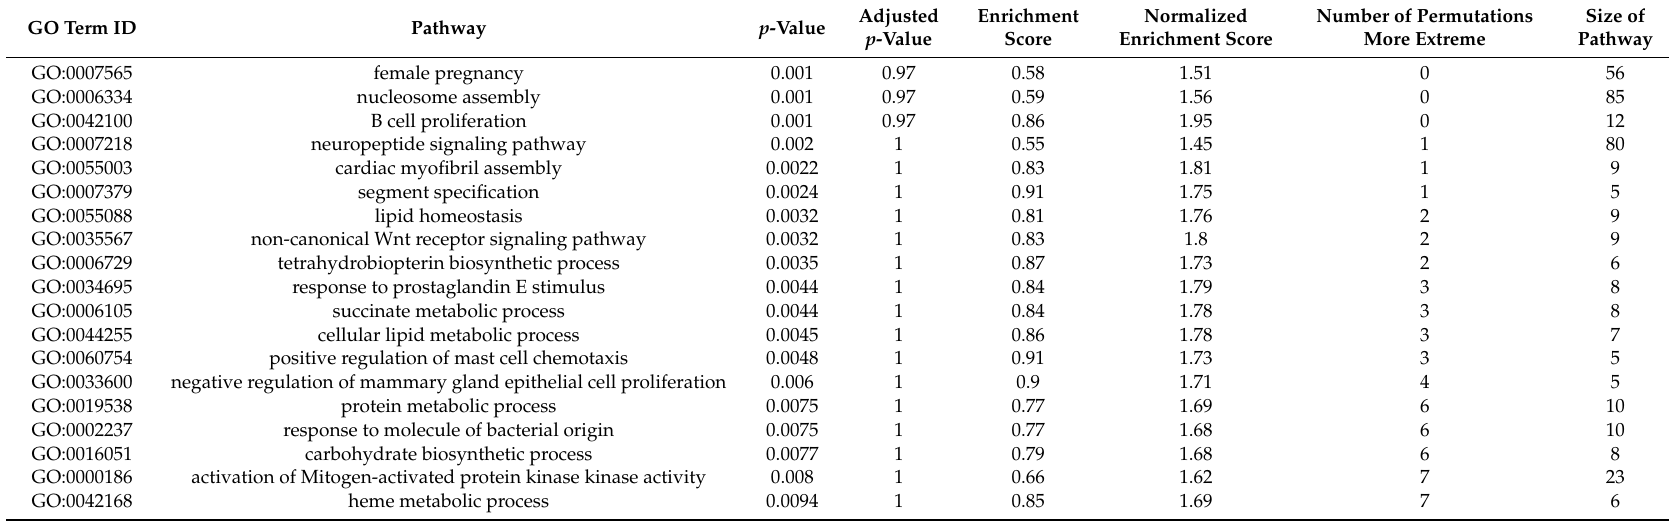
Table 2. Top gene ontologies enriched among di ff erentially methylated genes associated with low perinatal Pb exposure (2.1 ppm) relative to control treated